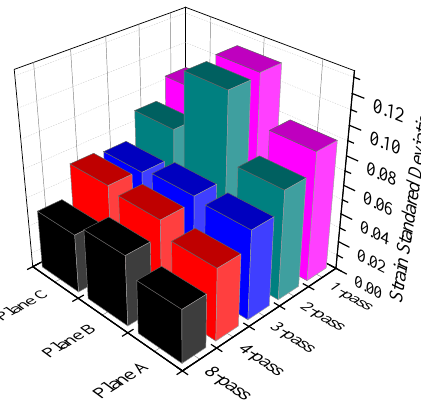
Figure 6. The effect of pass number on SSD for ECAPed Ti 49.2 Ni 50.8 alloy.